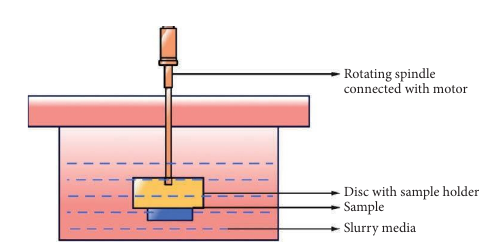
Figure 2: Slurry erosion tester.